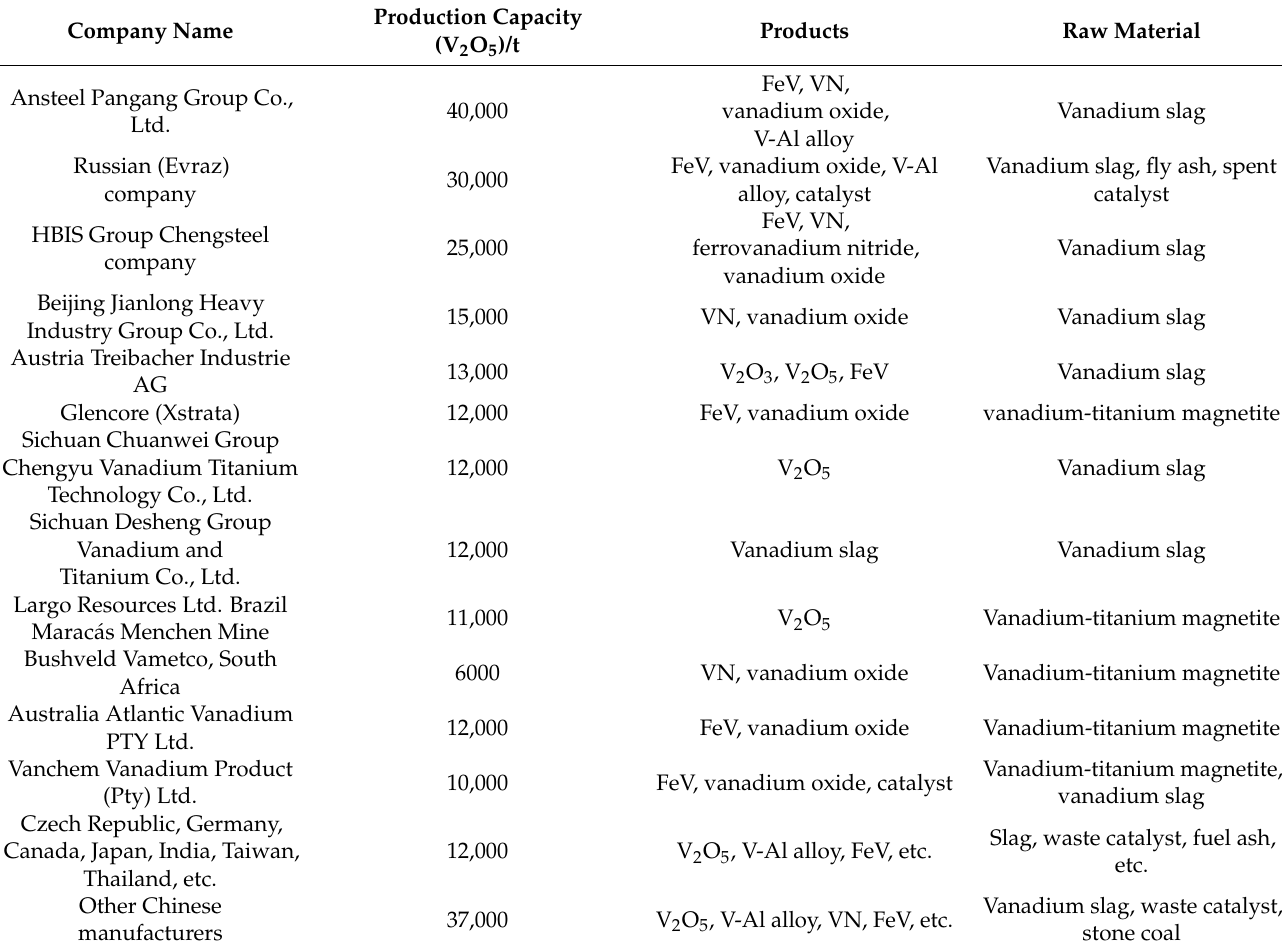
Table 3. Overview of major vanadium producers in the world in 2018